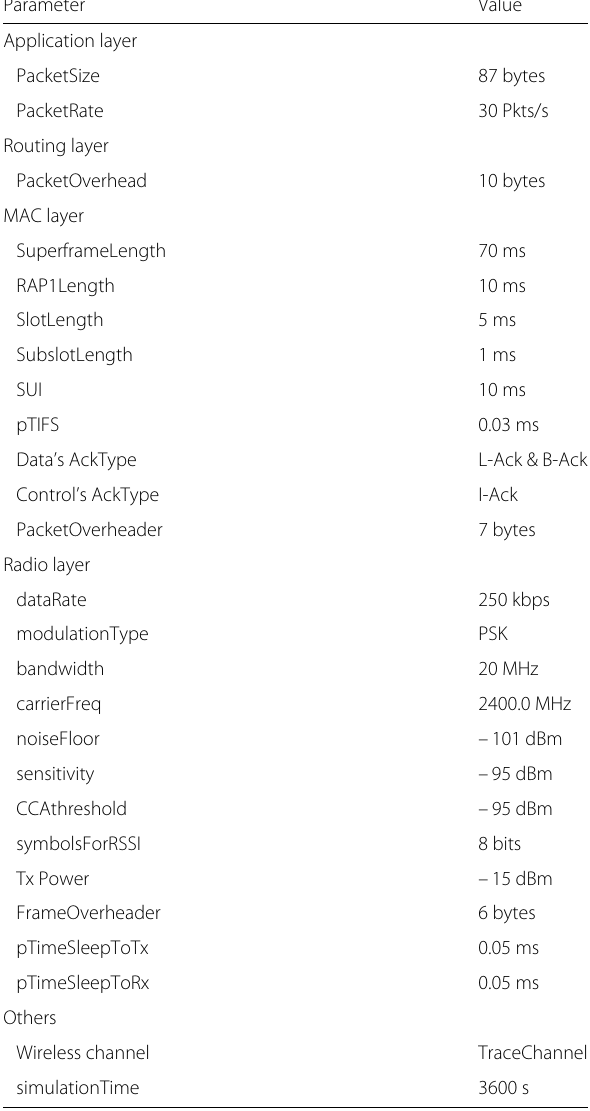
Table 1 Simulation parameters for